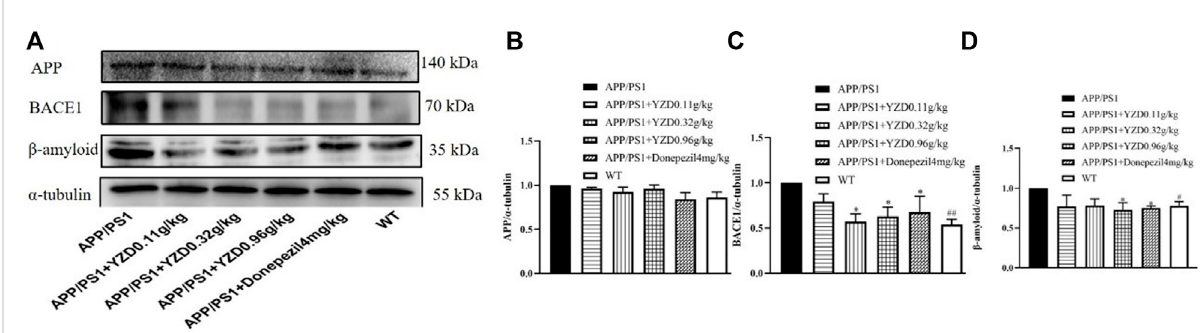
FIGURE 7 YZD treatment for 3 months reduces BACE1 and beta-amyloid protein abundance in the hippocampi of APP/PS1 transgenic mice. (A) Western blotanalysisofAPP,BACE1,beta-amyloidlevels.DensitometrydataofAPP (B) ,BACE1 (C) andbeta-amyloid (D) .Valuesrepresentedasthemean±SE